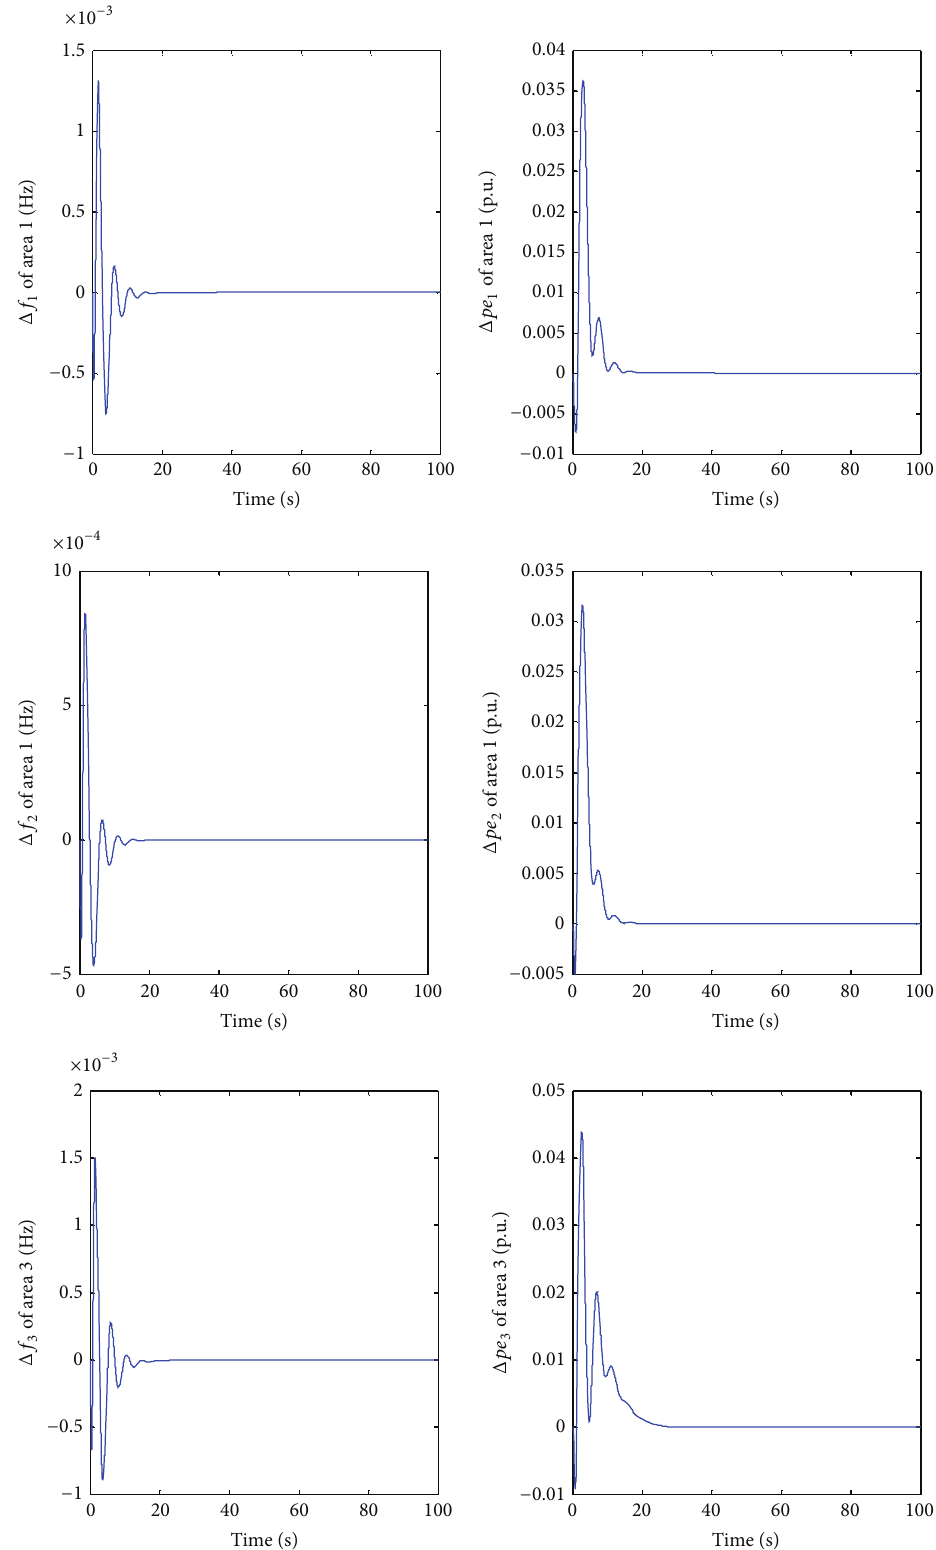
Figure 12: Step responses and observation errors of the expanded system when two original-construction subsystems are designed by LQG approach and 𝐸 2,3 varies from 1 to